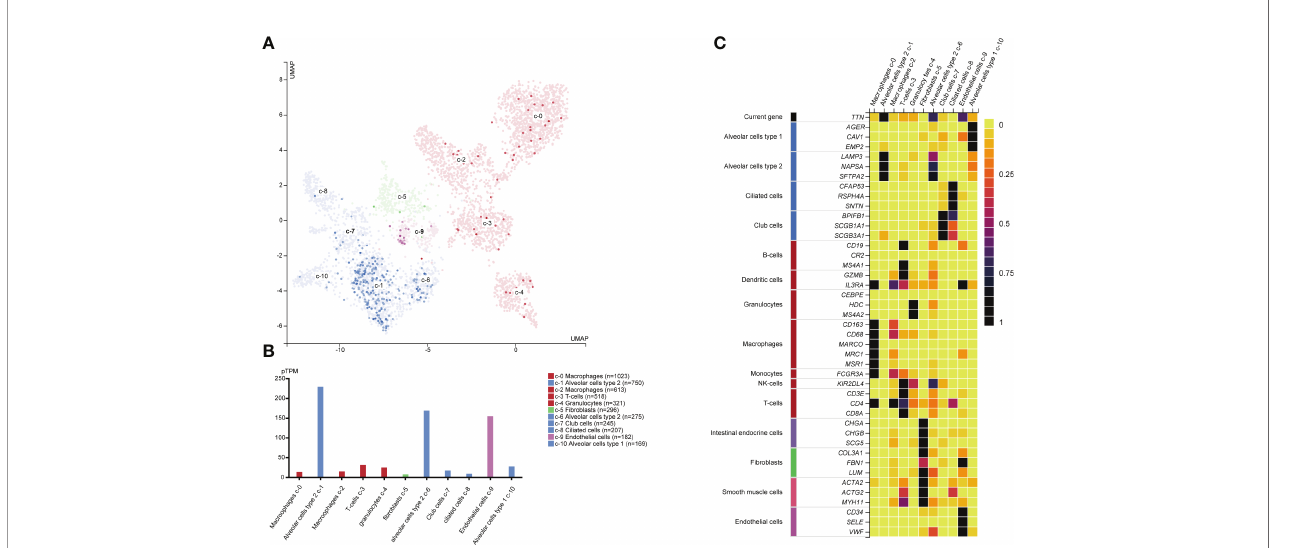
FIGURE 4 | TTN mRNA expression and other related cell type markers in different single cell type clusters of lung tissue. Expression of TTN in the single-cell type clusters identi fi ed in lung tissue was visualized by a UMAP plot (A) and a bar chart (B) Each dot corresponds to a cell. The heatmap (C) of TTN and speci fi c marker genes in each cell cluster subtype.